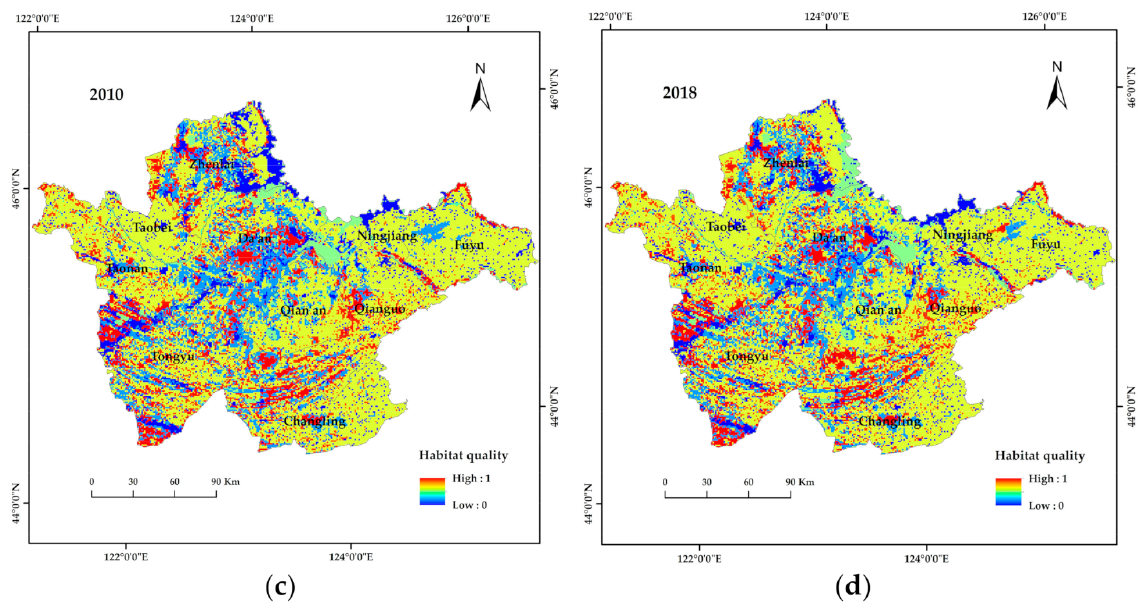
Figure 9. Spatial distribution of habitat quality index values in western Jilin Province from 1990 to 2018. ( a – d ), spatial distribution of habitat quality in western Jilin Province in 1990, 2000, 2010 and 2018,